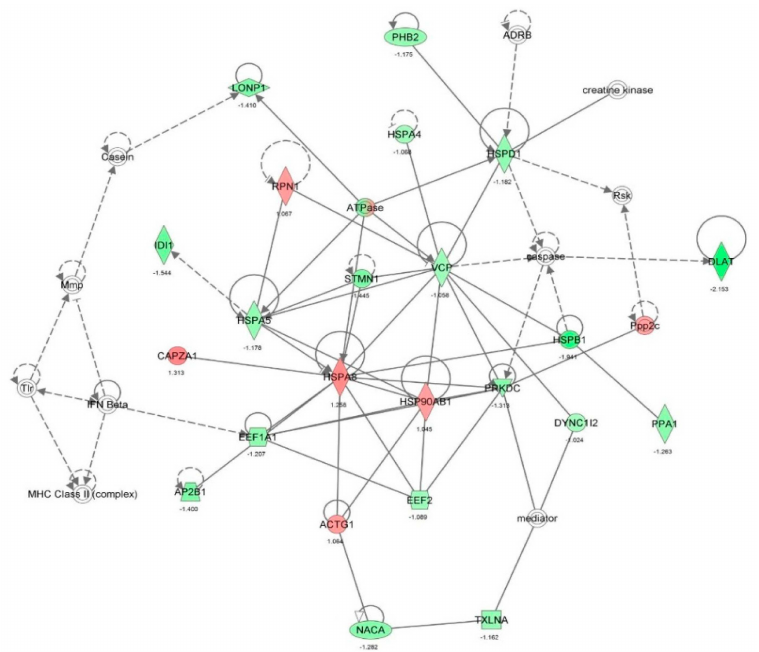
Figure 13. Vancomycin regulated post-translational modification, protein folding, and cell morphology. Red indicates an up-regulation; green indicates a down-regulation. The intensity of green and red colors indicates the degree of down- or up-regulation. Solid arrow indicates direct interaction and dashed arrow indicates indirect